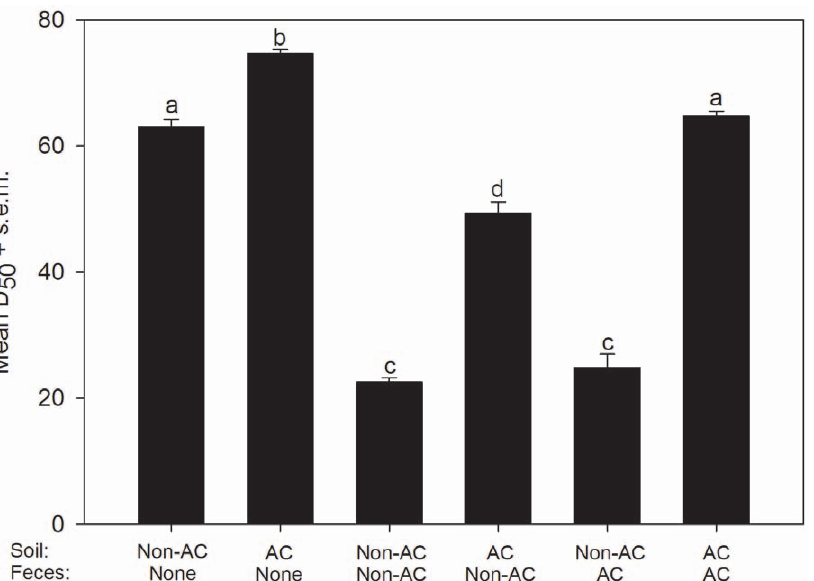
Figure 2. Soil mircoflora is responsible for degradation of ceftiofur metabolites. Effect of autoclaved (AC) vs. non-autoclaved (non-AC) soil and feces on ceftiofur metabolites (CFM) as measured by recovery of growth for E. coli K-12 (D 50 ). Sandy soil was used and chambers were incubated at 4 u C. Main effects (soil and feces) were significant ( P , 0.0001). Letters designate group differences based on Tukey-Kramer multiple comparison test ( P , 0.001).